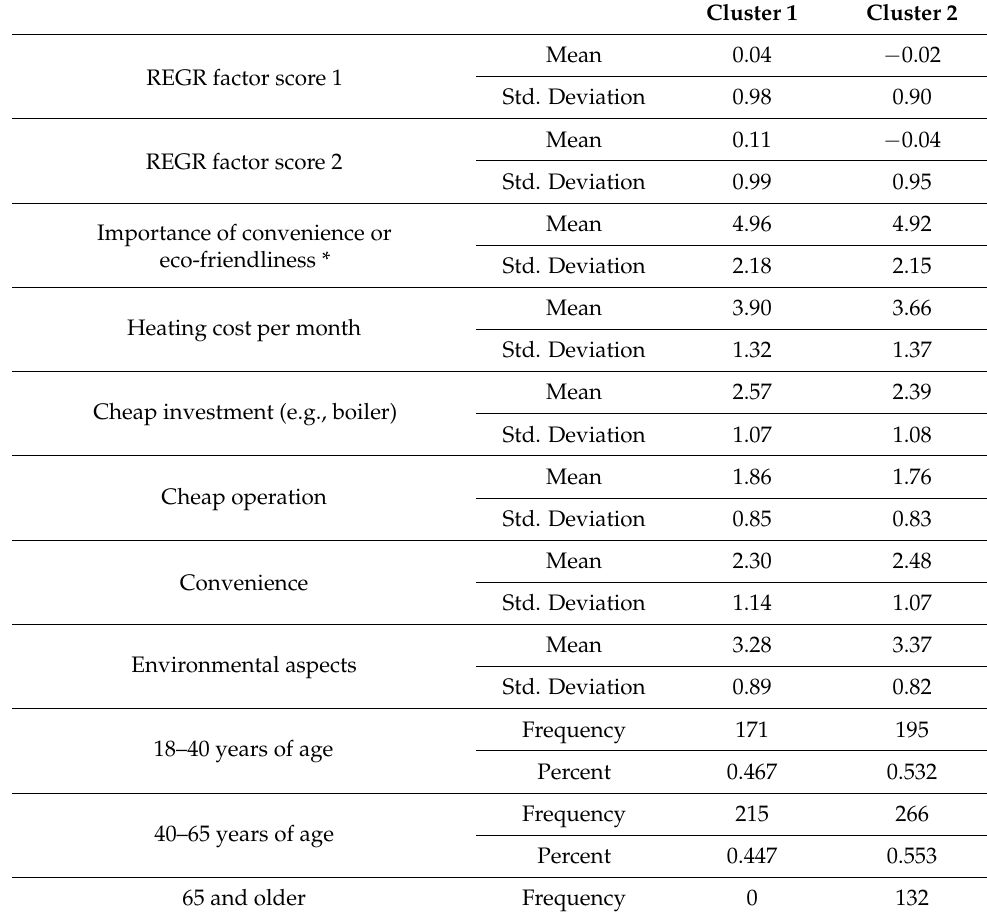
Table 10. Aspects of cluster